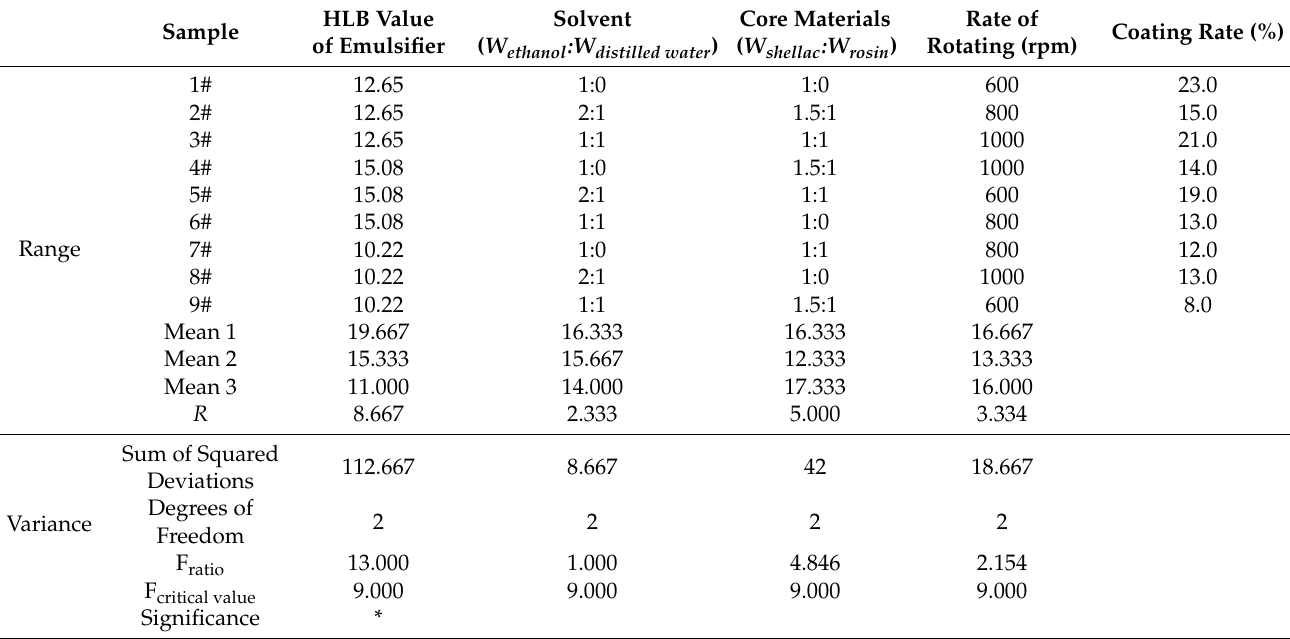
Table 7. Range and variance results of the coating rate of